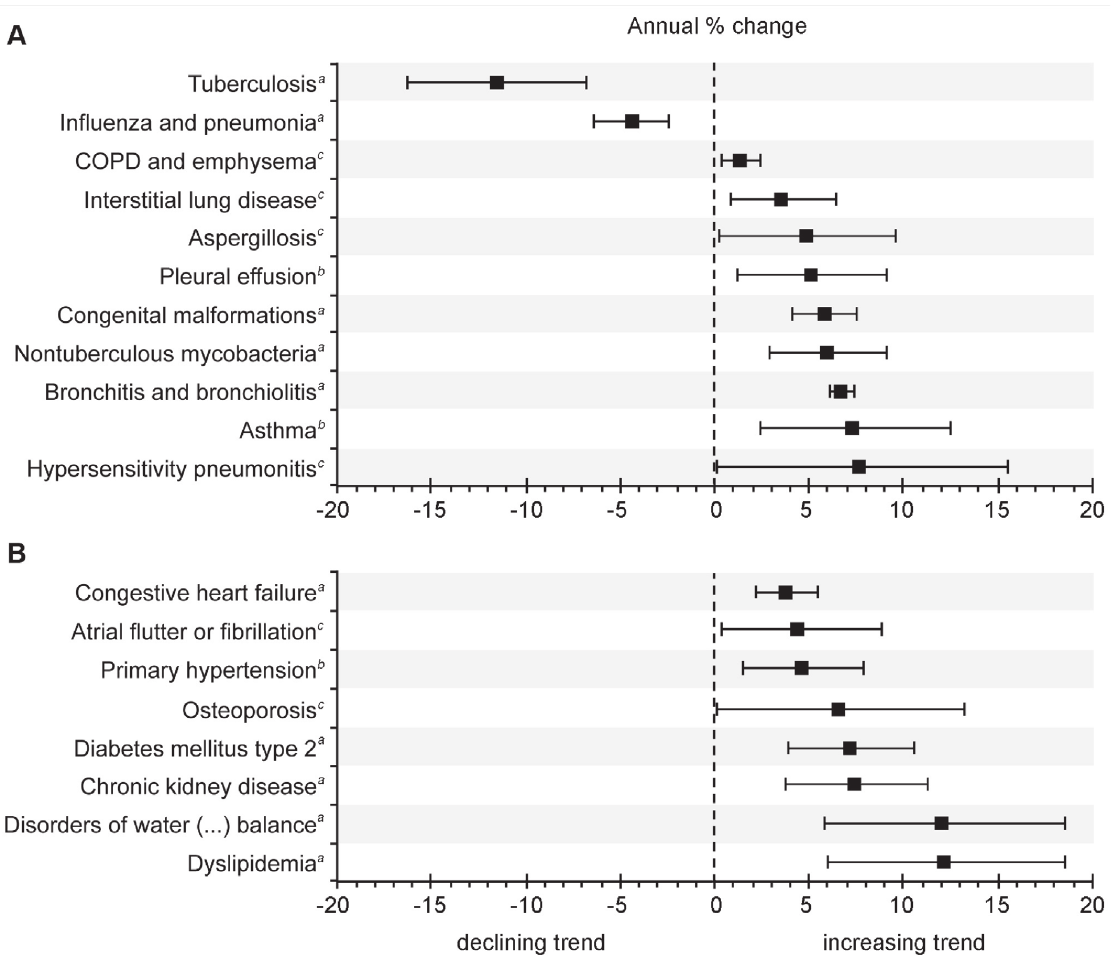
Figure 3. Average annual percentage change of the rate of associated primary and secondary diagnoses. Average annual percentage change of the rate of associated primary and secondary diagnoses per 1,000 hospitalizations with any diagnosis of bronchiectasis, Germany, 2005– 2011, among (A) diagnoses commonly associated with bronchiectasis and (B) bronchiectasis-unrelated comorbidities. Non-significant trends are not shown. Bars indicate 95% confidence intervals calculated from Poisson log-linear regression analysis (Wald statistics). a Statistical significance at P , 0.001. b Statistical significance at P , 0.01. c Statistical significance at P , 0.05.